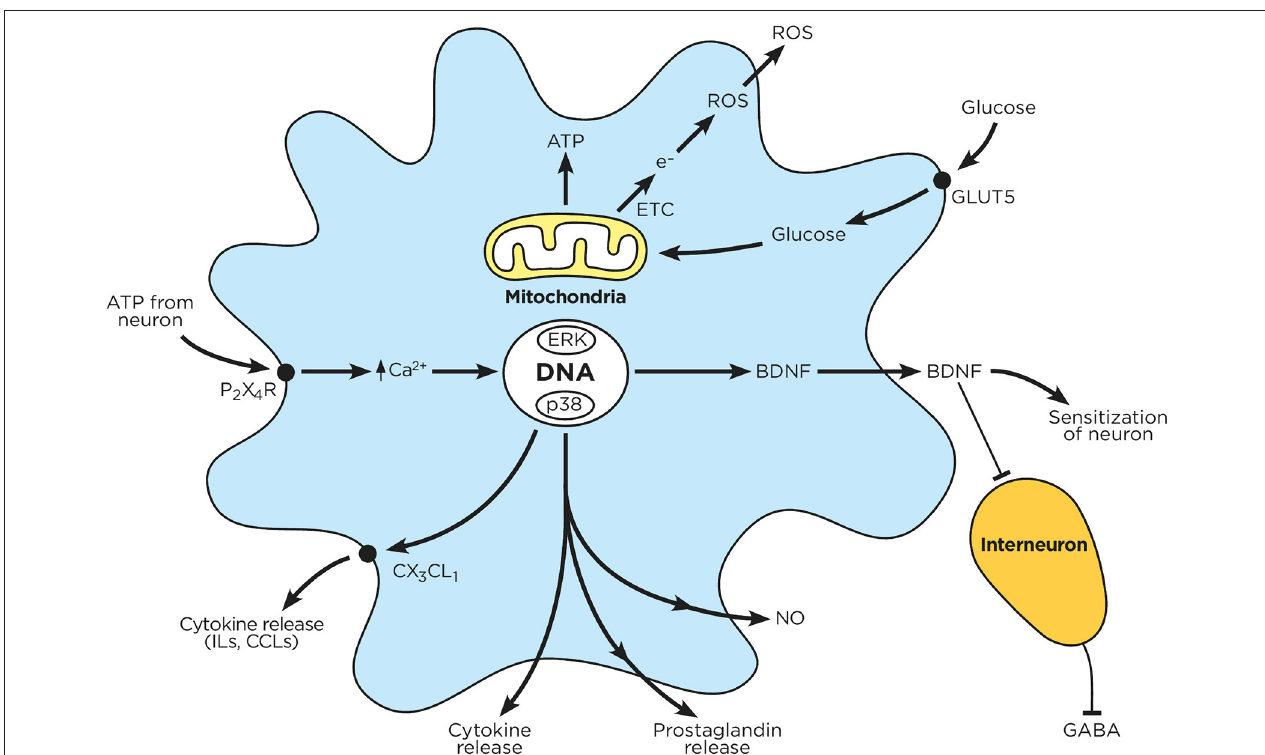
FIGURE 3 | Chronic hyperglycemia impairs microglial function. Circulating glucose is taken up by microglia, which enhances mitochondrial ATP production and electron transfer. The released electrons combine with intracellular oxygen to produce reactive oxygen species. Sensory neurons release ATP, which in turn activates microglial P 2 X 4 R; this drives microglial calcium influx, MAPK activation, receptor phosphorylation and protein transduction (cytokines, prostaglandins, BDNF) as well as NO production. These mediators are subsequently released by microglia, and either block inhibitory interneurons or enhance neuronal